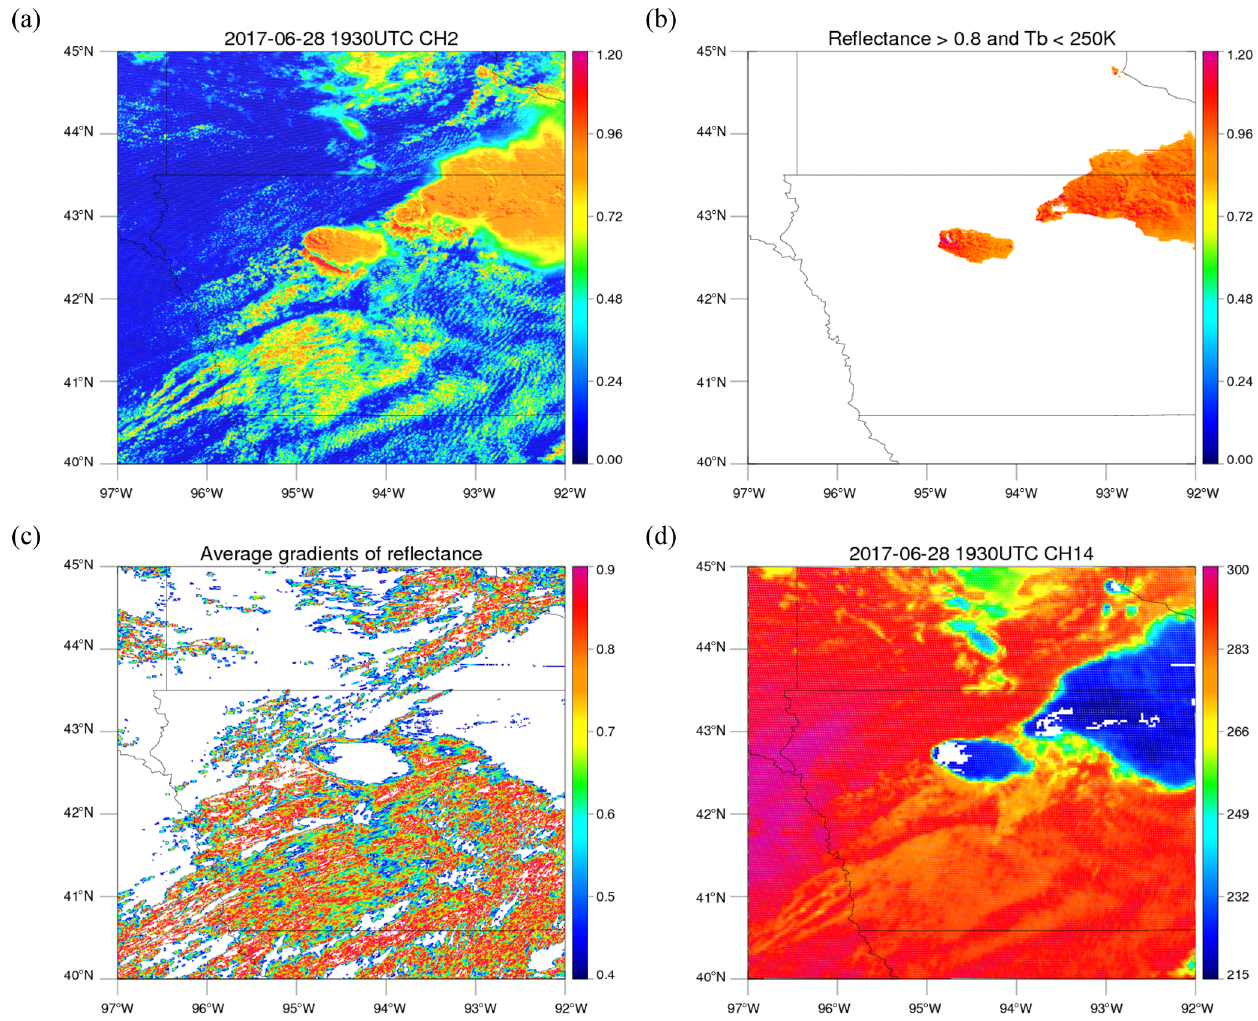
Figure 5. (a) Same as Fig. 3a, but using different color table. (b) From the reflectance map in (a) , regions that have reflectances over 10min less than 0.8 or have T b values greater than 250K over 10min are assigned reflectance of zero, and therefore colored in white. (c) Map of average gradients of reflectances over 10min. Regions with average gradient less than 0.4 or greater than 0.9 are colored in white. (d) GOES- ABI 11.2µm infrared channel imagery (K) at 19:30UTC on 28 June 2017. Regions that passed two criteria from (b) and (c) are colored in